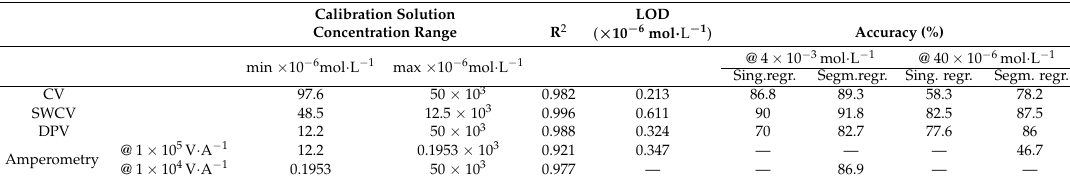
Table 4. Calibration of the various electroanalytical schemes for dopamine detection. Abbreviations: Single regression (Sing. regr.), Segmented regression (Seg.